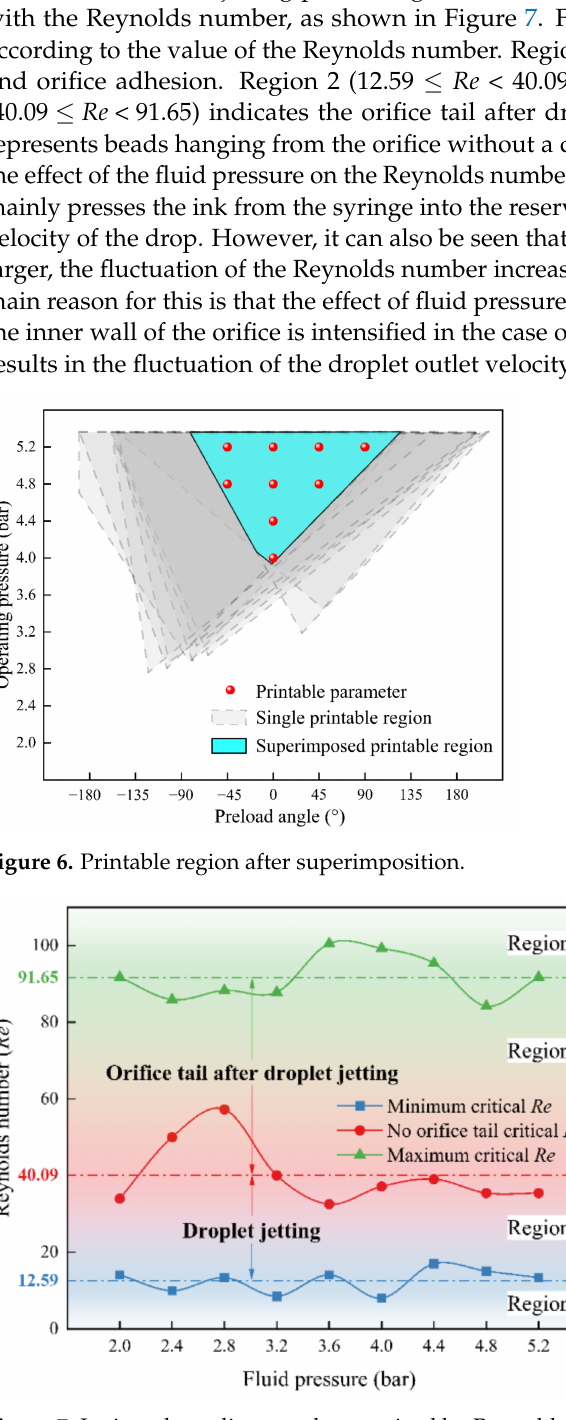
Figure 7. Jetting phase diagram characterized by Reynolds